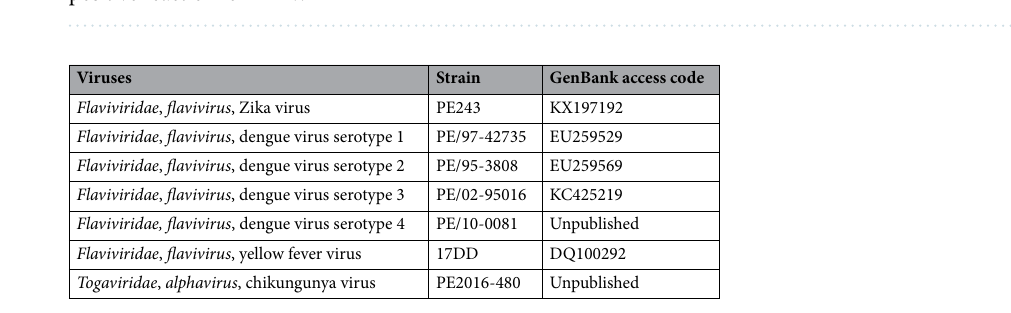
Figure 2. Detection of ZIKV in virus-spiked body fluid samples. Biological samples including urine, serum, saliva and semen were spiked with either a high (1 × 10 6 PFU/mL) or low viral load (1 × 10 3 PFU/mL) and processed for RT-LAMP without RNA extraction ( A – I ). The RT-LAMP results were observed by visual color change of the products in the reaction tube and by gel electrophoresis. Amplification products were observed by naked eye natural light ( A , C , E and G ), under UV irradiation ( B , D , F and H ) and agarose gel electrophoresis (I). Legends in ( A – I ) are: (1) NTC (non-template control): water; (2): uninfected biological sample (urine, serum, saliva and semen); (3): biological sample infected with 10 6 PFU/mL; (4): biological sample infected with 10 3 PFU/mL. M: molecular weight marker. Orange color: negative reaction for ZIKV; Greenish yellow color: positive reaction for ZIKV.